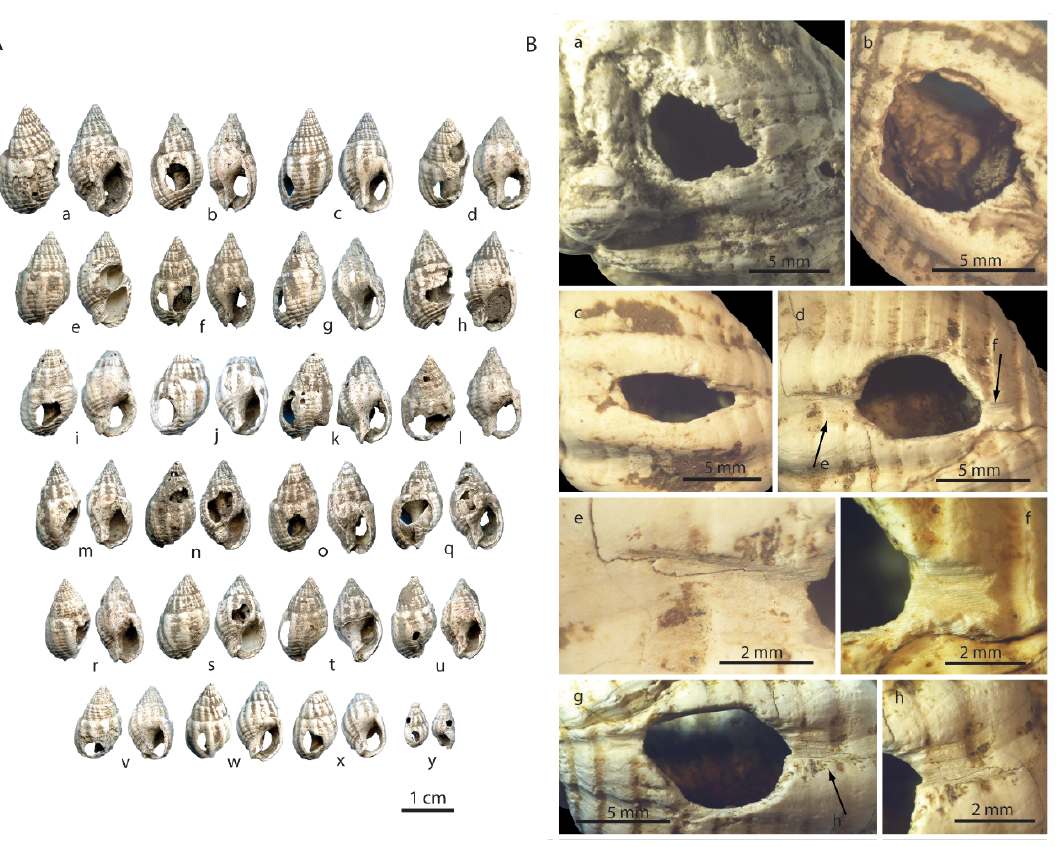
Figure 8: A) perforated Tritia reticulata , B) macrophotos of the perforations: probable anthropogenic dorsal perforations on the last spire whorl (a, b), dorsal anthropogenic perforations with longitudinal striations made by scraping the last spire whorl (c-h).